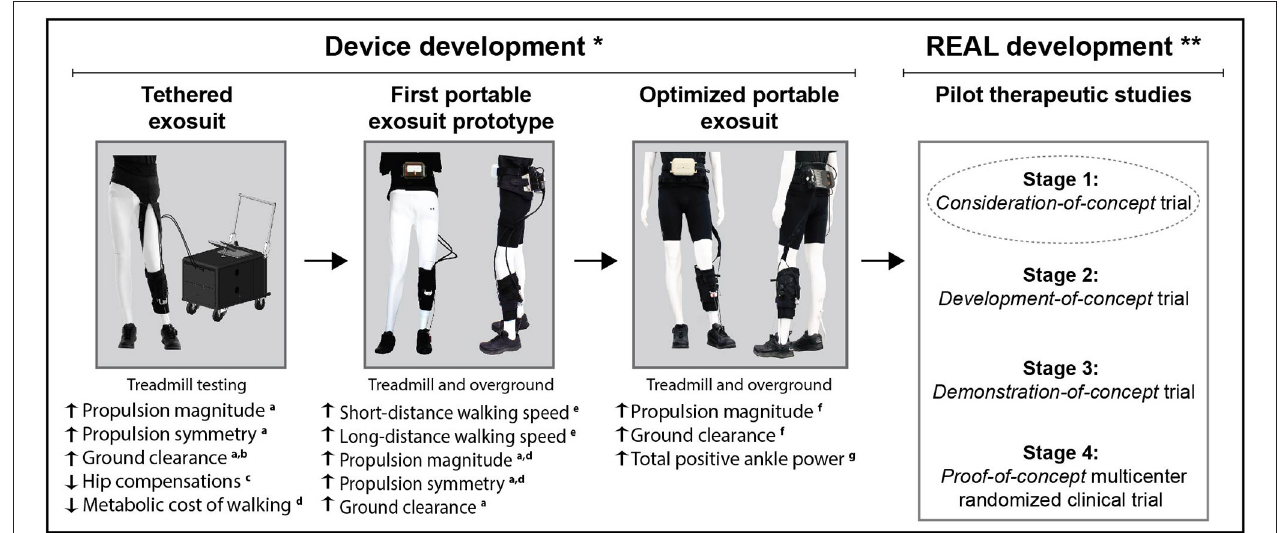
FIGURE 1 | Progression of our stroke exosuits program from device development to development of the Robotic Exosuit Augmented Locomotion (REAL) gait training program. a, Awad et al. (2017a); b, Bae et al. (2015); c, Awad et al. (2017b); d, Bae et al. (2018b); e, Awad et al. (2020a); f, Bae et al. (2018a); g, Siviy et al. (2020). *Single-session comparisons of exosuit powered vs. unpowered (or not worn); **Multi-session evaluations of pre-to-post training effects of REAL gait